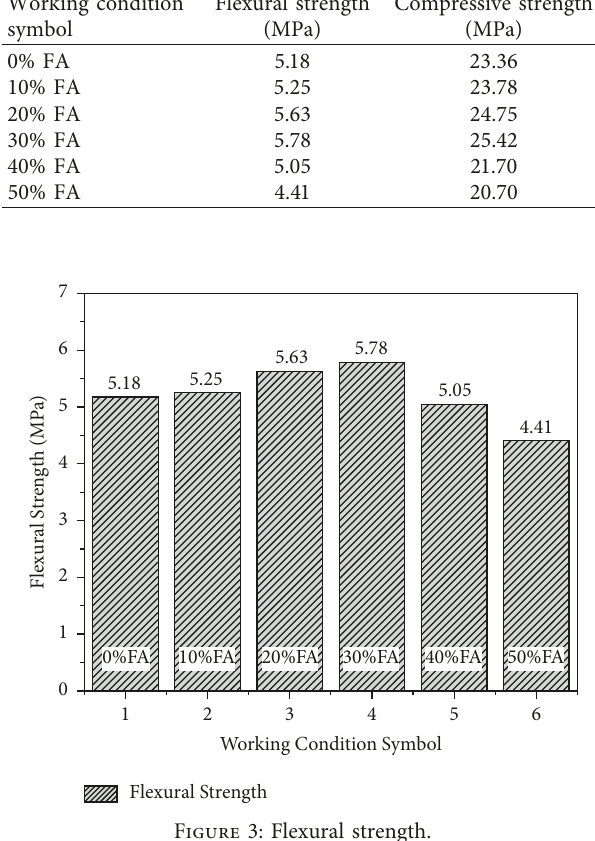
Figure 3: Flexural